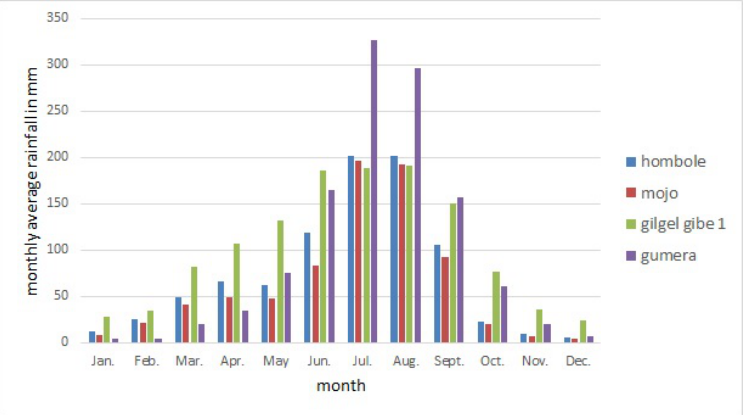
Figure 1. Homboleand Mojo watersheds in the Upper Awash River Basin.